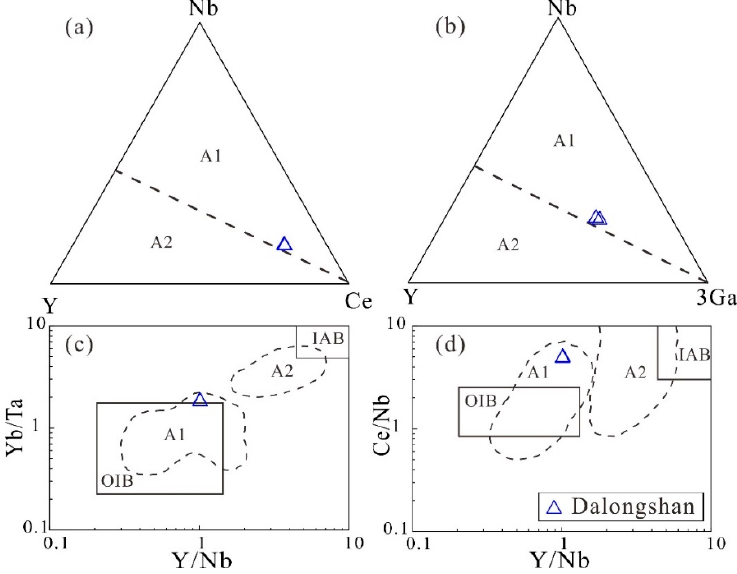
Figure 16. Discrimination diagrams of A-type granites. ( a – d ) are modified from [20,82,83],